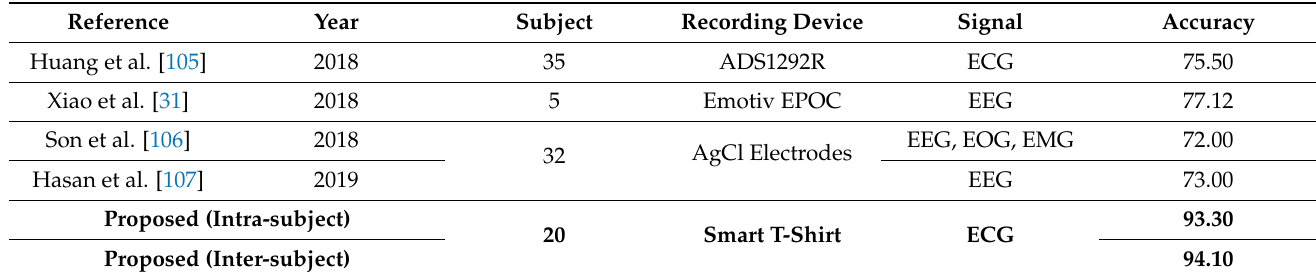
Table 5. Comparison between previously selected and proposed